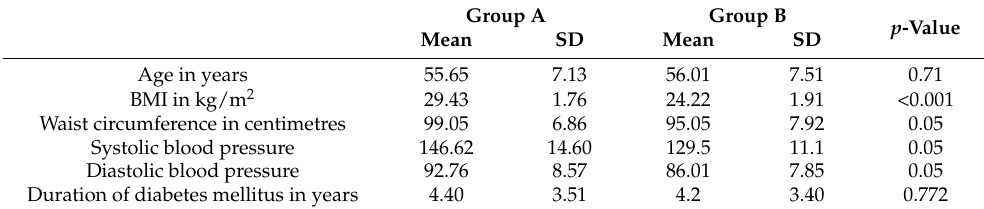
Table 1. Demographic details of the patients in both groups.